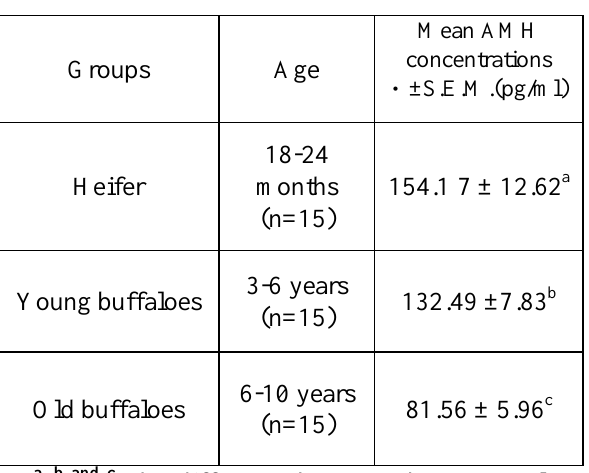
Table 1: Concentrations of serum AMH in the heifer, young, and old buffaloes groups on Day 0.